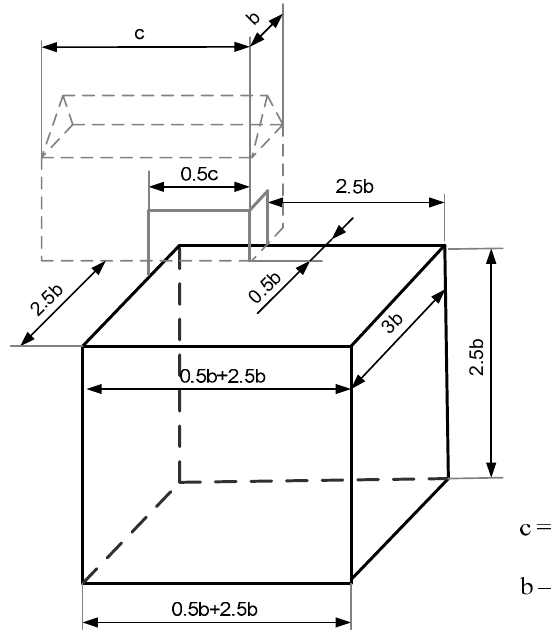
Figure 3. Geometry of the 3D model.